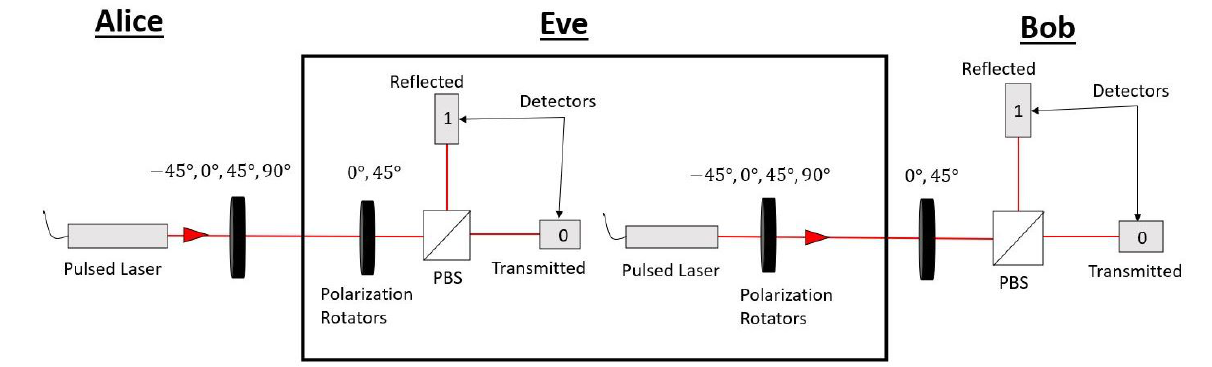
Figure 6. Optical diagram with Alice, Bob and